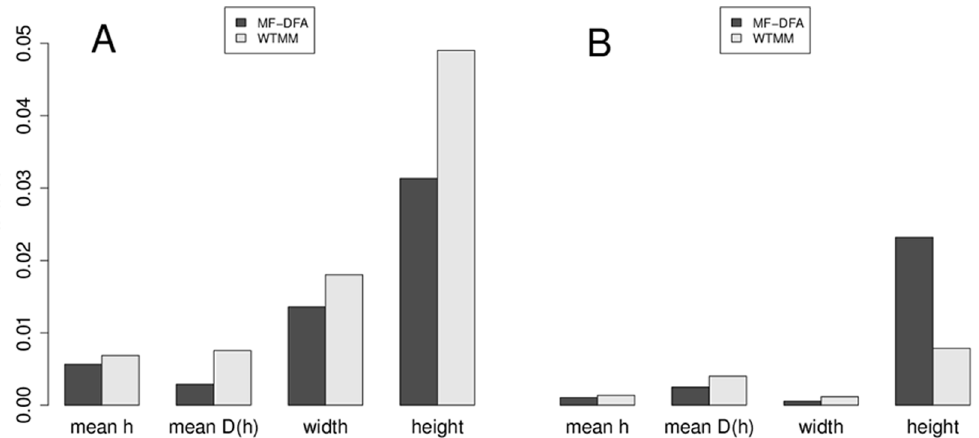
Figure 2. Variance comparison between MF-DFA and WTMM techniques. A . For 14 subjects with 8 m of waking EEG each, divided into 30 s segments (16 segments of n=7500 data points each per subject), multifractal spectra were calculated (total of 224 segments). Mean Ho¨lder exponent value (mean_h), width of the Ho¨lder exponents (width_h), mean fractal dimension (mean_D(h)) value, and height of the multifractal singularity spectrum (height_D(h)) were calculated for each segment. B . The 14 subjects’ 8 m of waking EEG were analyzed whole, and multifractal specta were calculated. Note the trend to reduced variance with increasing length of EEG tracing.